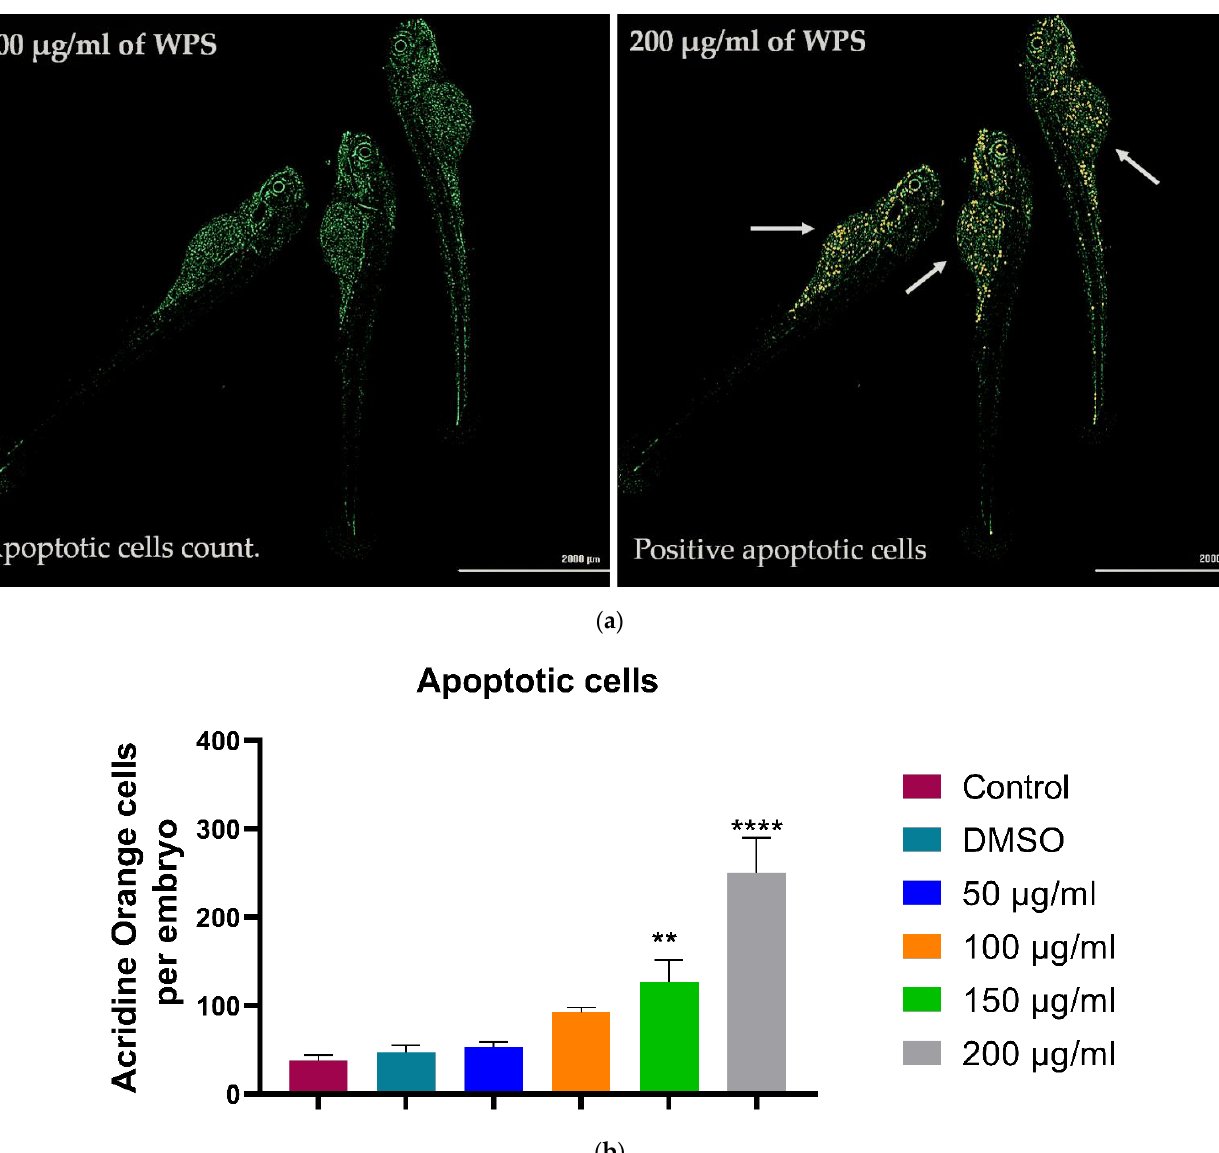
Figure 8. Quantitative apoptosis for apoptotic cells using Acridine Orange (AO). ( a ) Repetitive image of embryos exposed to highest WPS concentration (200 µg/mL) stained with acridine orange and showing positive apoptotic cells. ( b ) Quantitative analysis using a microplate assay revealed that apoptosis increased in a dose-dependent manner. All data are presented as mean ± SEM (experiments were carried 3 times in triplicate). The analysis was done by one-way ANOVA with the Dunnett test. * p < 0.05, ** p < 0.01, *** p < 0.001 and **** p < 0.0001.